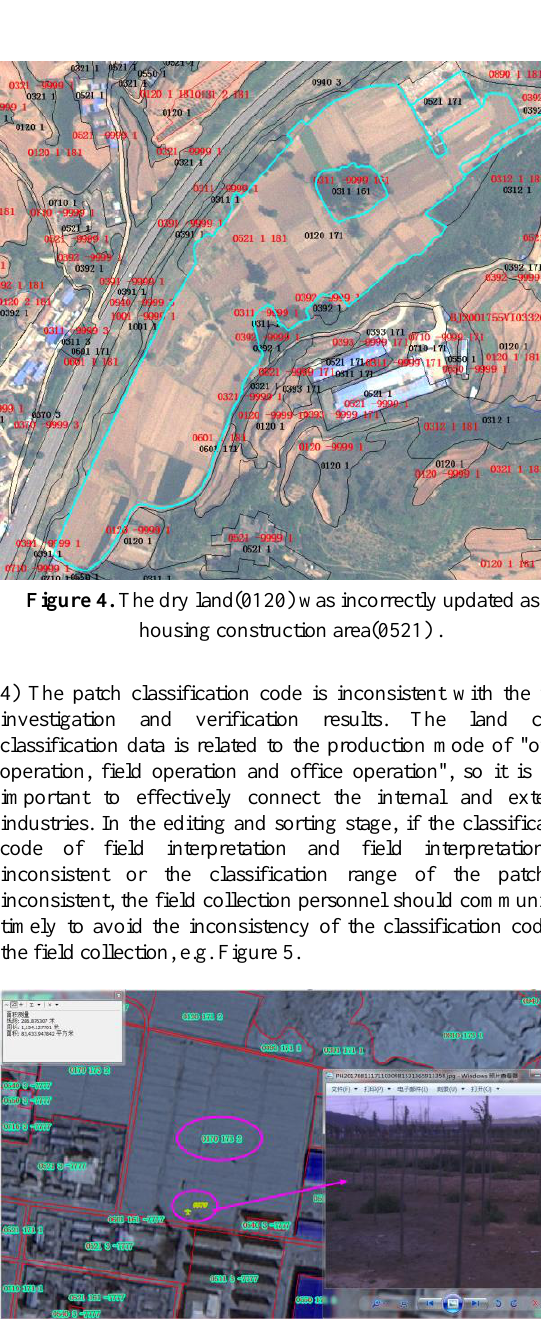
Figure 5. Field verification data is planted young forest (0370), but the results is expressed as nursery (0170) .